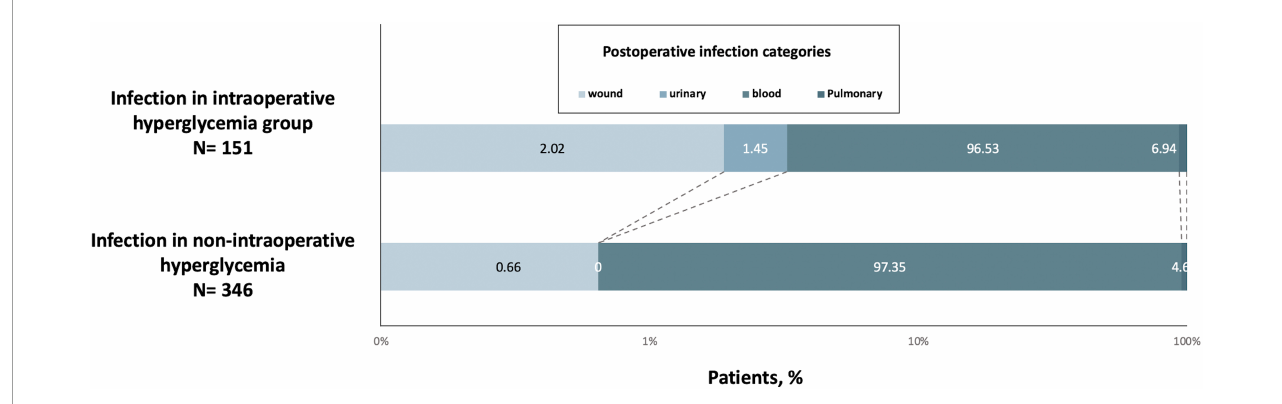
FIGURE2 Postoperative infection categories the intraoperative hyperglycemia group ( n = 151) or control ( n = 346) groups.